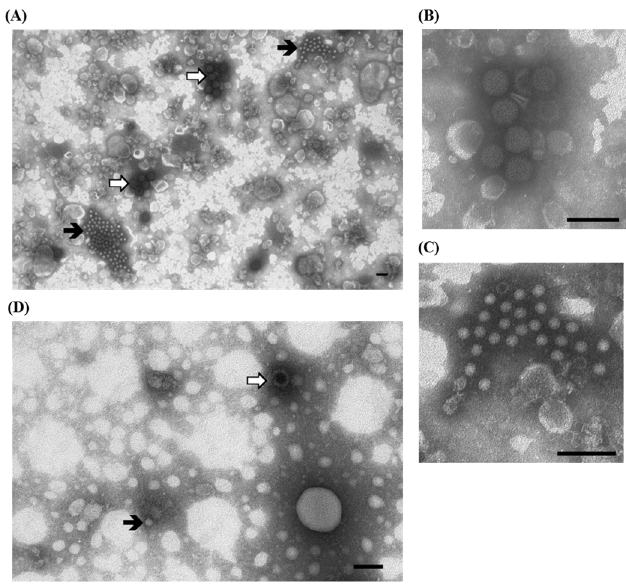
Figure 5. Electron micrographs of ultracentrifuged gut contents from 12—to 15-day-old turkeys. ( A ) Aggregates of both larger, roundish, 60–70 nm rotaviruses (  ) and smaller, icosahedral non-enveloped 25–27 nm astroviruses (  ), surrounded by a fuzzy halo of antibodies are visible; ( B ) Higher magnification of rotavirus particles: the presence of a halo of antibodies does not mask the typical single—and double-shelled morphology of rotaviruses; ( C ) Higher magnification of astrovirus particles: the surface of aggregated virions, even if not always distinctively showing the 5–6 star-shaped pattern, do not have a completely homogeneous or featureless surface, which is highly indicative of astroviruses; ( D ) IAEM negative control: one isolated rotavirus (  ) and one astrovirus-like particle (  ) are visible. Immuno-aggregation electron microscopy (IAEM) preparation with convalescent sera diluted 1:40. Negative staining (2% sodium phosphotungstate). TEM Philips CM10, 80 kV. Bar = 100